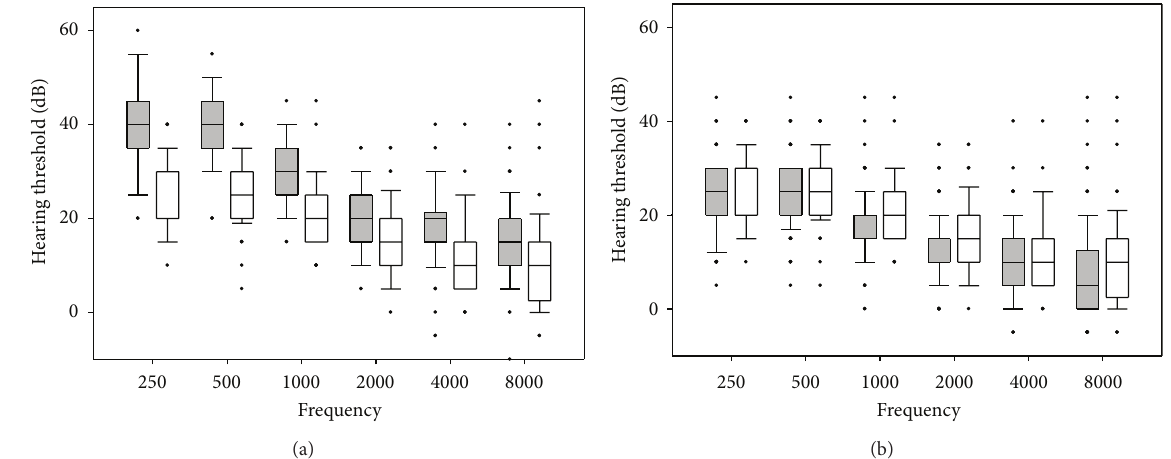
Figure 1: (a) Audiometry data on 80 patients with uncomplicated malaria before treatment (shaded) and 57 healthy controls (open). Box plots show mean, quartiles, 95% and 5% percentiles, and outliers. Data for right ear have been shown in all figures; measurements on the left ear gave essentially identical results throughout. Hearing thresholds were significantly higher in patients than in controls across all wavelengths (two-way repeated measurement ANOVA on ranks 𝑃 < 0.001 , post hoc test significant ( 𝑃 < 0.05 ) for all wavelengths). (b) Audiometry data on 58 patients followed up 9–12 months after an attack of uncomplicated malaria (shaded) and 57 healthy controls (open, same as in (a)). Hearing thresholds were significantly lower in recovered patients than controls across all wavelengths and both ears (two-way repeated measurement ANOVA on ranks 𝑃 = 0.01 , median difference <